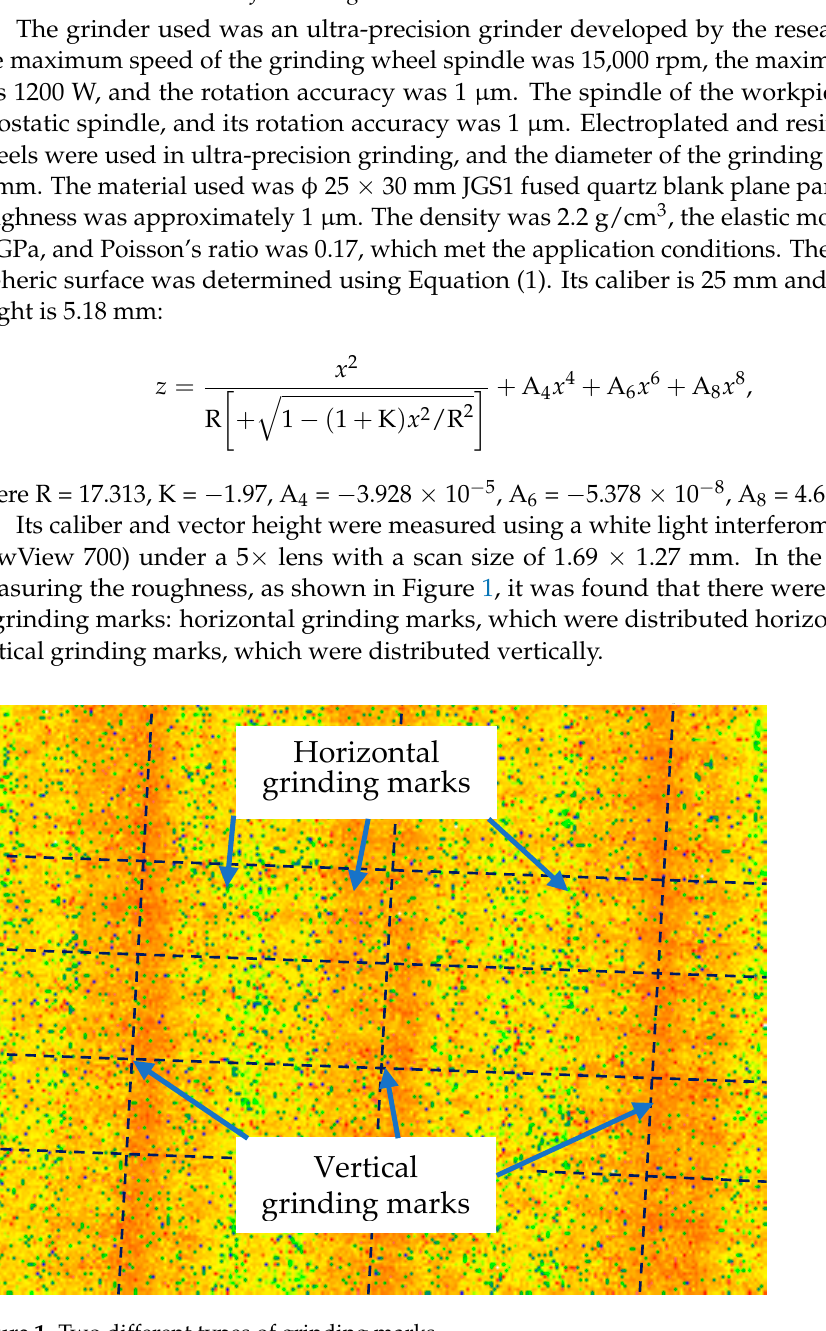
Figure 1. Two different types of grinding marks.